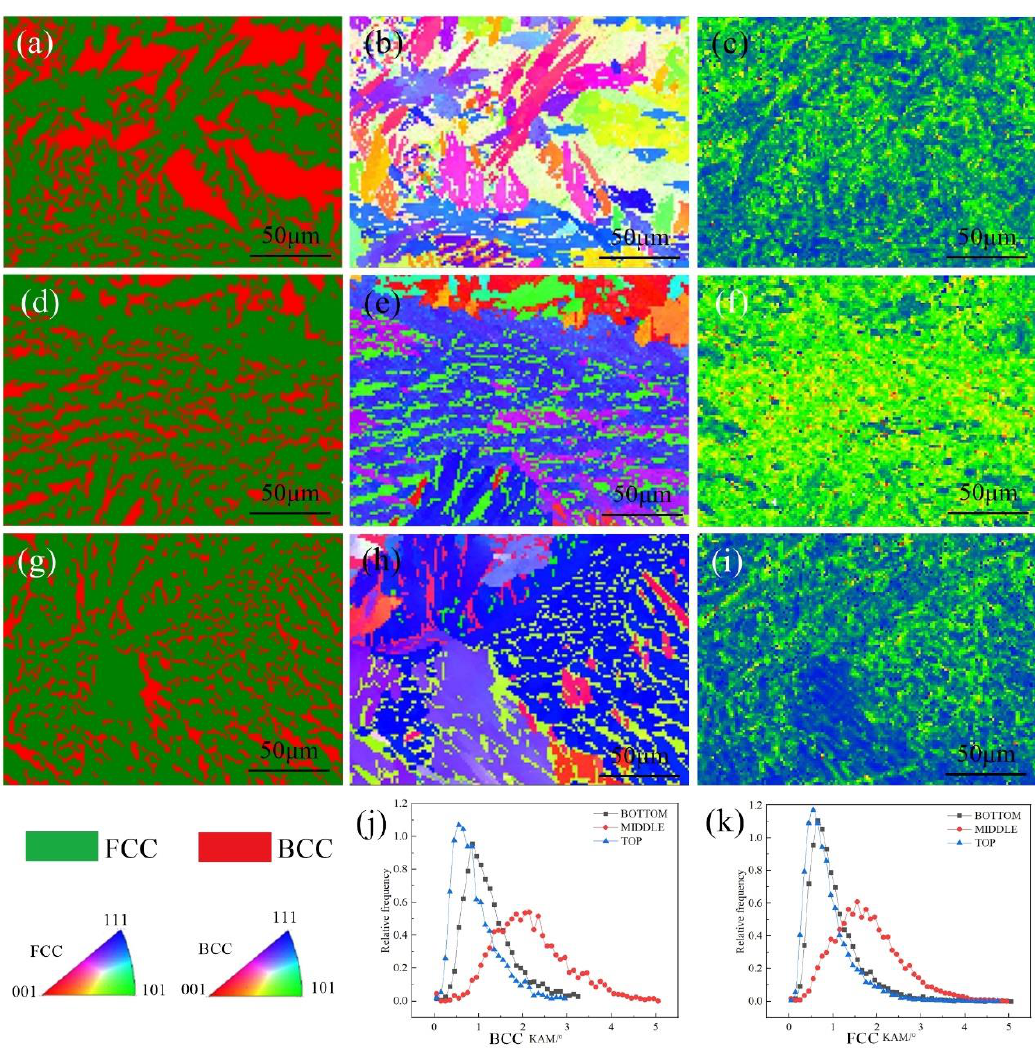
Figure 4. EBSD analysis of additive parts ( a , d , g ) phases distribution at bottom, middle and top area; ( b , e , h ) distribution of grain orientation at bottom, middle and top area; ( c , f , i ) KAM at bottom, middle and top area; KAM-angle distributions for BCC ( j ) and FCC ( k ).